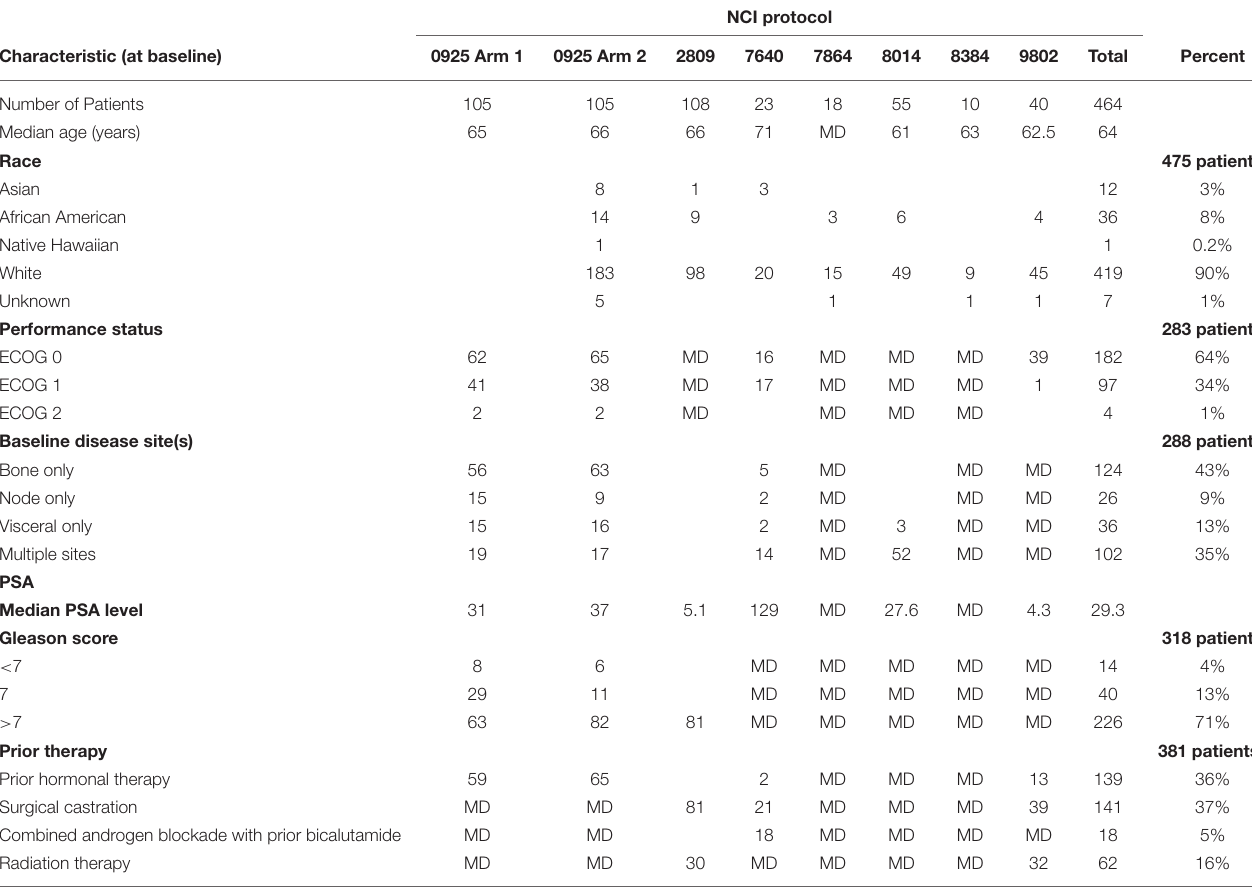
TABLE 2 | Patient or tumor characteristics and prior therapies.